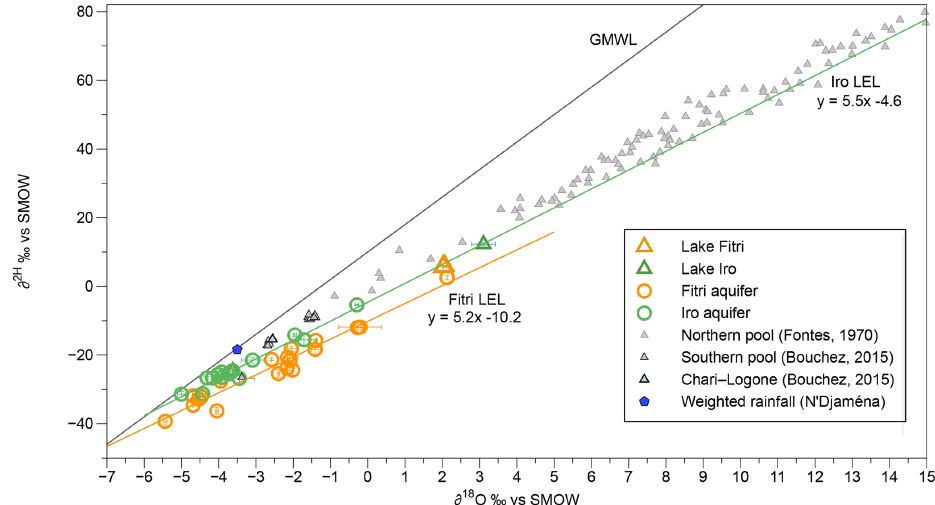
Figure 4. Relation between δ 18 O and δ 2 H (‰ vs. SMOW, Standard Mean Ocean Water) for surface water and groundwater samples from Iro Lake and Lake Fitri. Iro Lake’s groundwater (green) forms a local evaporation line (LEL) on which the data from Iro Lake and Lake Fitri are plotted (triangles). Lake Fitri’s groundwater forms another LEL below that of Iro Lake. In grey, Lake Chad data (Fontes et al., 1970) trace their own LEL ( y = 5 . 2 x + 1), which can be seen above the two previous lines. The weighted rainfall (from N’Djamena IAEA station) is in blue and the associated local meteoric water line (LMWL) equation is y = 6 . 3 x +